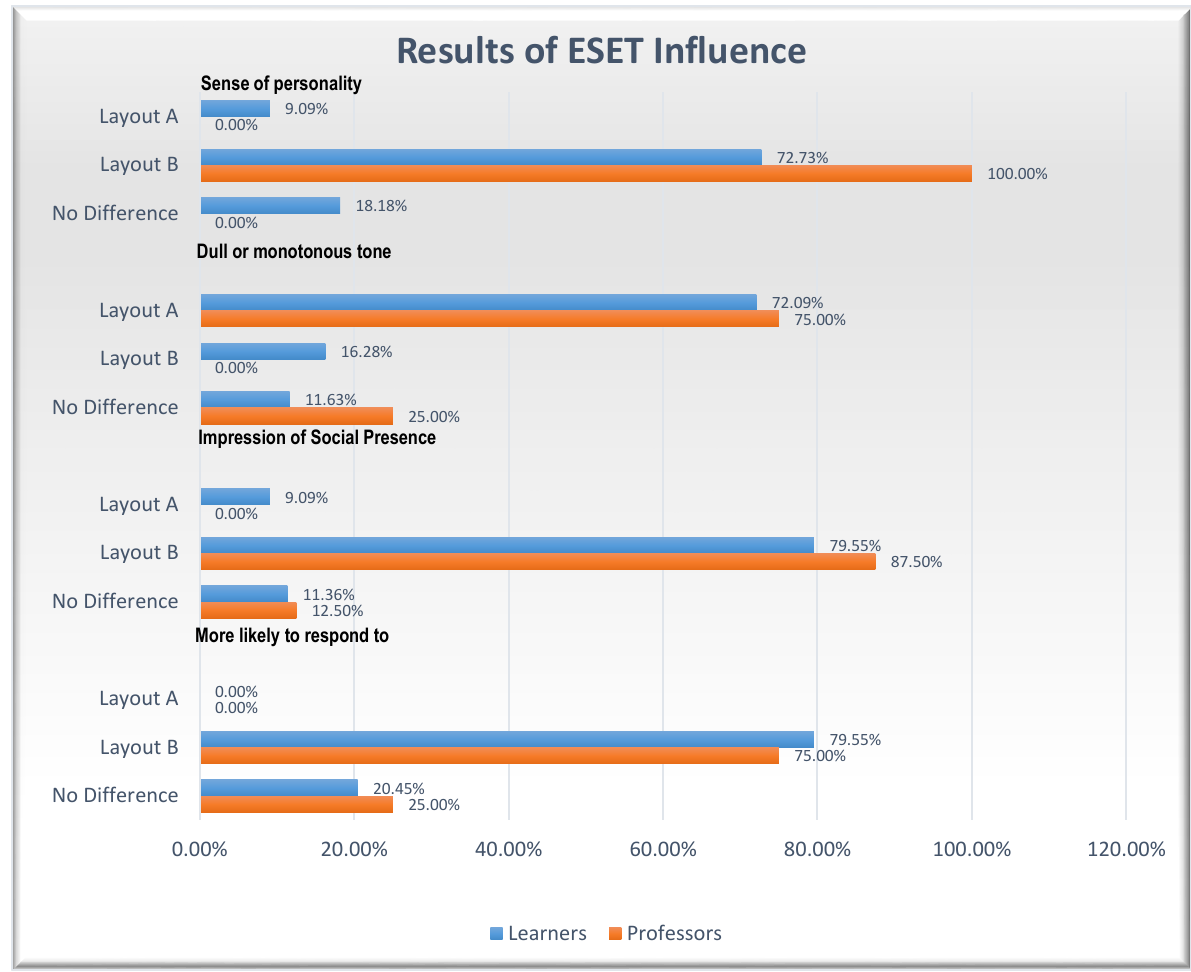
Figure 3 . Impressions about posts with same content but different